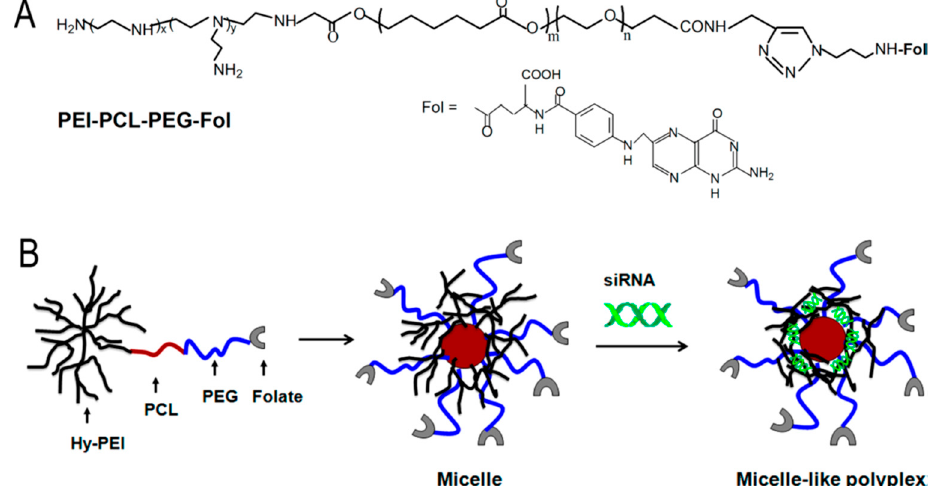
Figure 4. Chemical structure of polyethylenimine-graft-polycaprolactone-block-poly(ethylene glycol)-folate (PEI-PCL-PEG-Fol) ( A ) and schematic illustration of the micelle-like polyplex formation ( B ). Adapted with permission from Reference [114]. ( B ). Adapted with permission from Reference